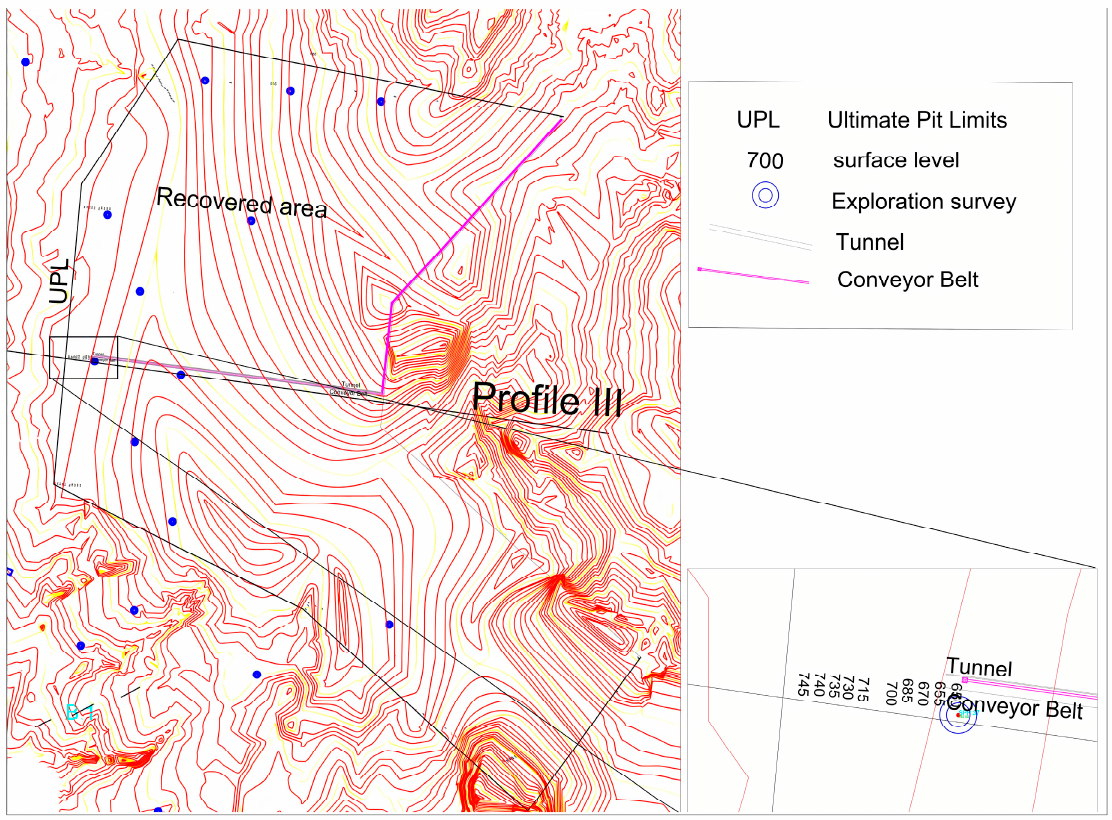
Figure 6. The final phase of environmental recovery showing the infrastructure (tunnel) built over the conveyor belt.